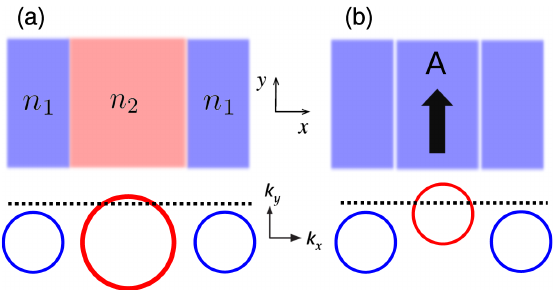
FIG. 1. Structures and isofrequency contours corresponding to two different waveguiding mechanisms: (a) index guiding, where the core region has a high refractive index and the cladding has a low refractive index; (b) gauge-field guiding, where the core region has a nonzero gauge potential A and the cladding has a zero gauge potential. The dashed line on the isofrequency contours demonstrates the absence of k -matching states in the y cladding